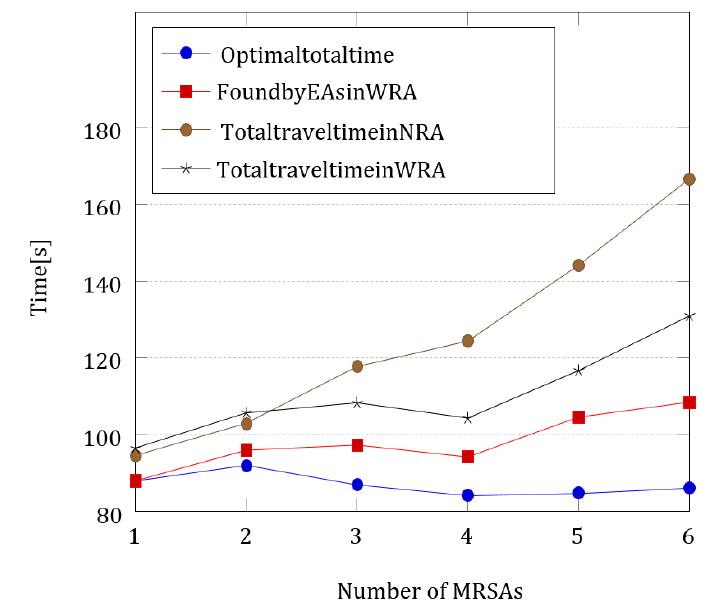
Figure 12. Comparison of the average times.